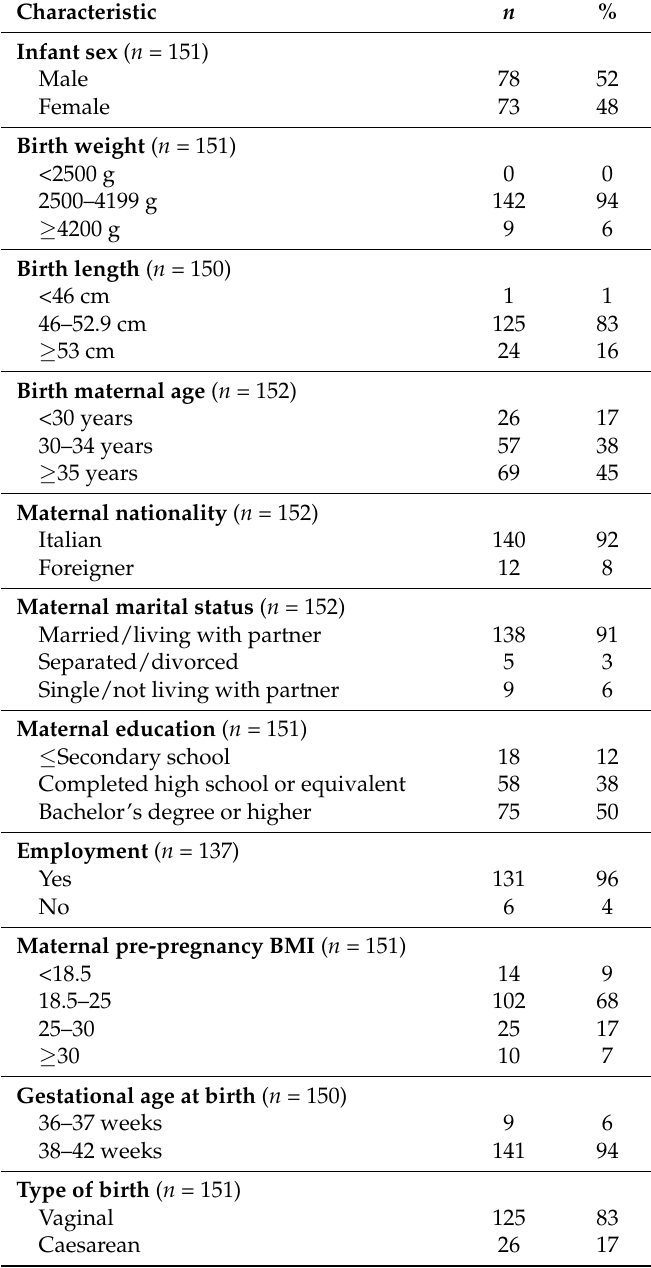
Table 1. Characteristics of mothers at enrolment and children at birth ( n =